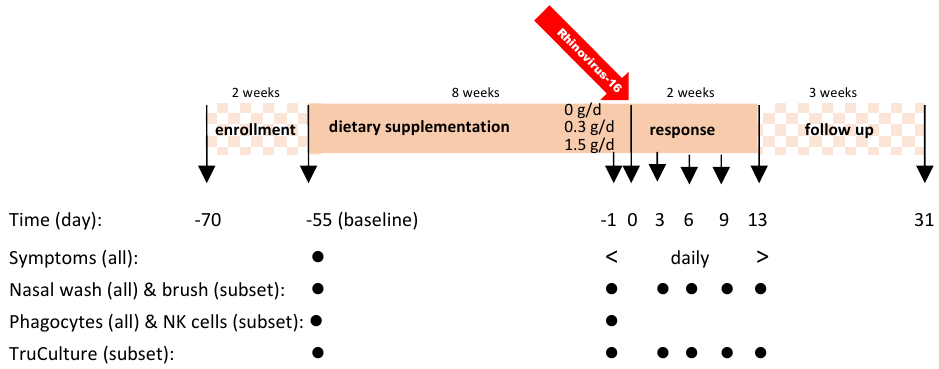
Figure 1. Study design and sampling moments. No dietary supplement taken during enrollment phase d-70 to d-55. Supplementation started on d-55 and continued through to d13. In the follow-up phase, without supplementation, safety parameters and seroconversion were assessed [13].